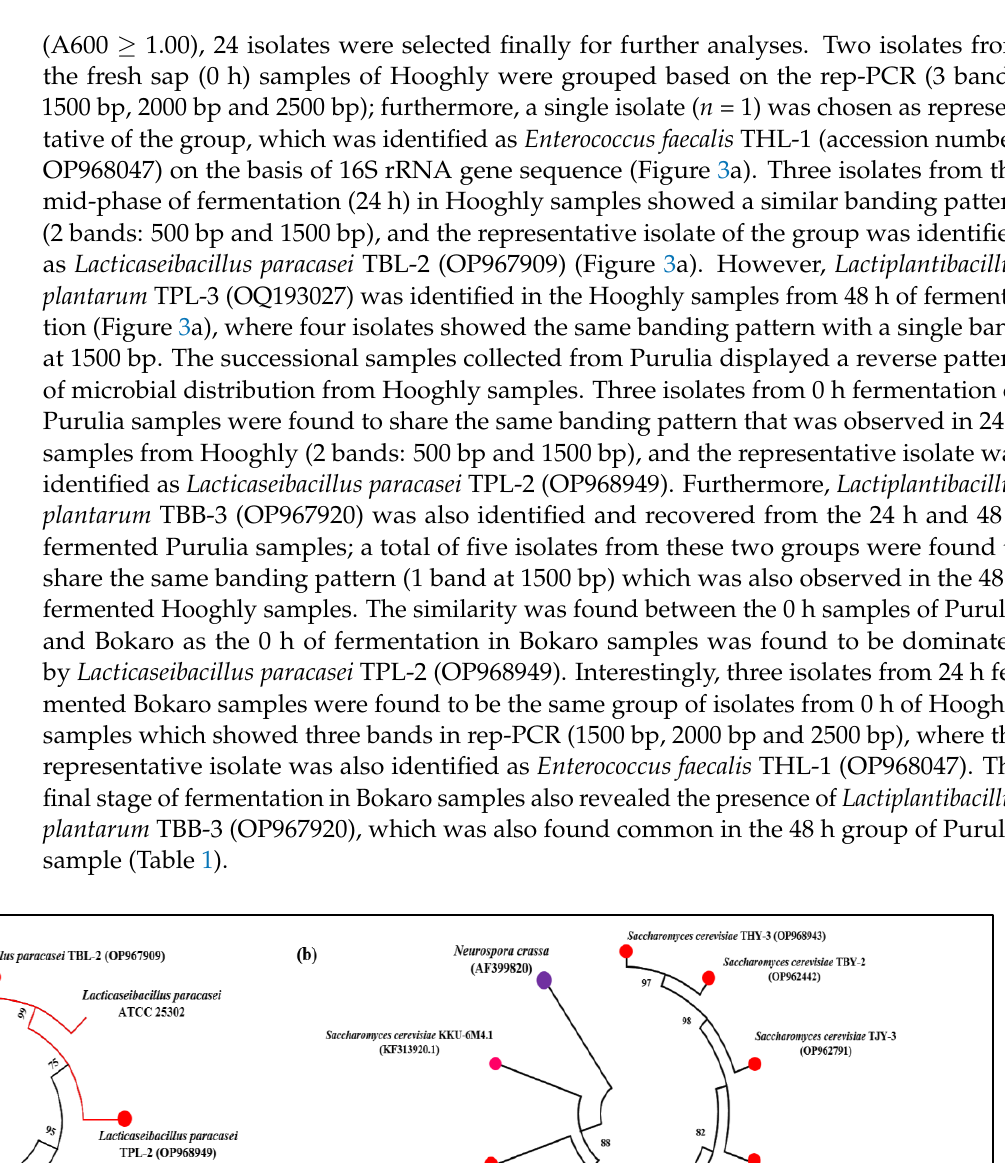
Figure 3. Phylogenetic tree representing the relationship between ( a ) bacteria and ( b ) yeast. The accession number is given within the parenthesis. Phylogenetic analyses of five bacterial isolates (based on 16S rRNA gene sequencing) and eight yeast isolates (based on the sequencing of the D1-D2 region of ribosomal LSU 26S rRNA gene) from taal and khejur toddy were performed using the neighbour-joining method in MEGA software v11.0.13 with Pseudomonas juntendi (NR180457.1) and Neurospora crassa (AF399820) as the outgroups for bacteria and yeasts, respectively. The number of bootstrap replications was kept default (1000). The type strains represent the closest relatives of the